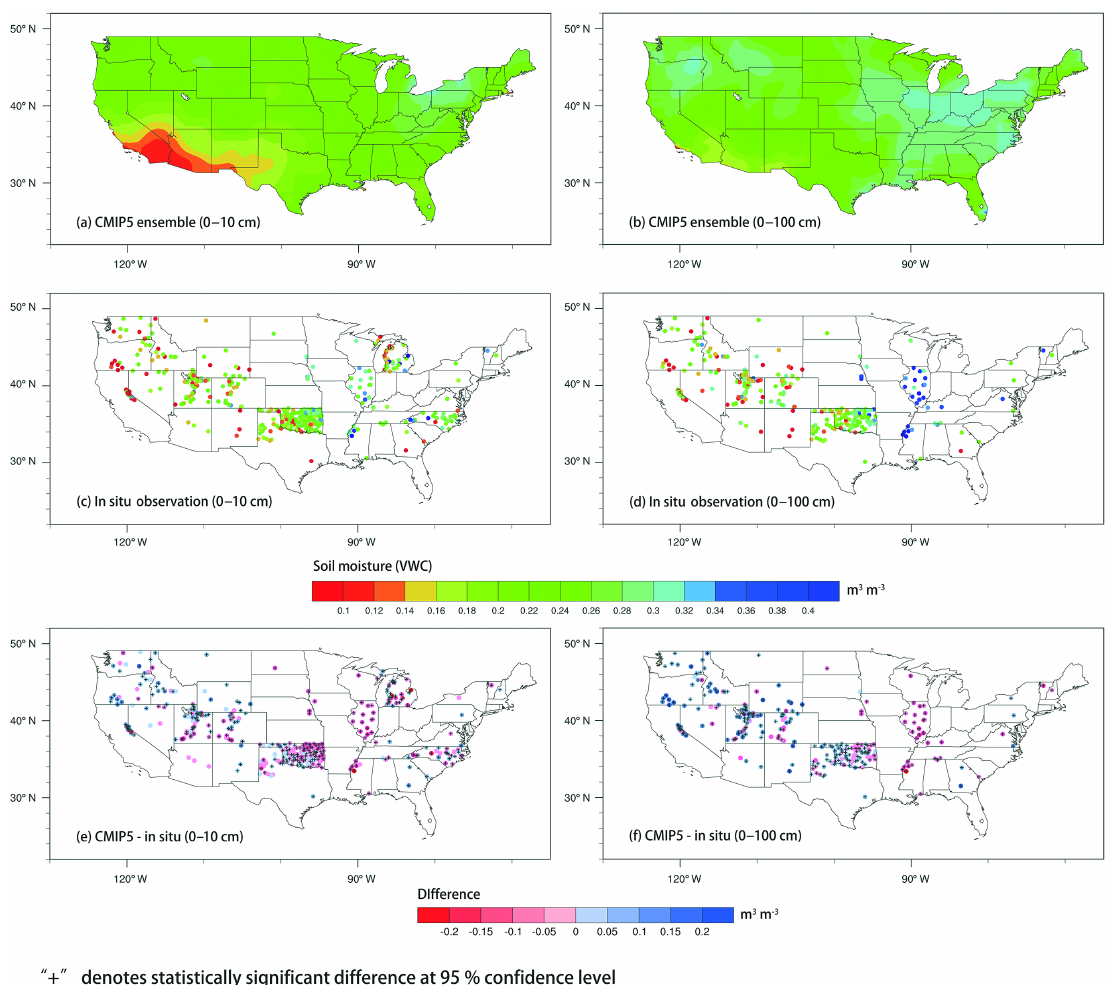
Figure 4. Mean soil moisture (m 3 m − 3 ) over CONUS (2003–2012) during the warm season (April to September). Left panels show the 0–10cm soil moisture for (a) CMIP5 ensemble, (c) in situ observations and (e) the difference between them (CMIP5 – in situ). Right panels show the 0–100cm soil moisture for (b) CMIP5 ensemble, (d) in situ observations and (f) the difference between them (CMIP5 – in